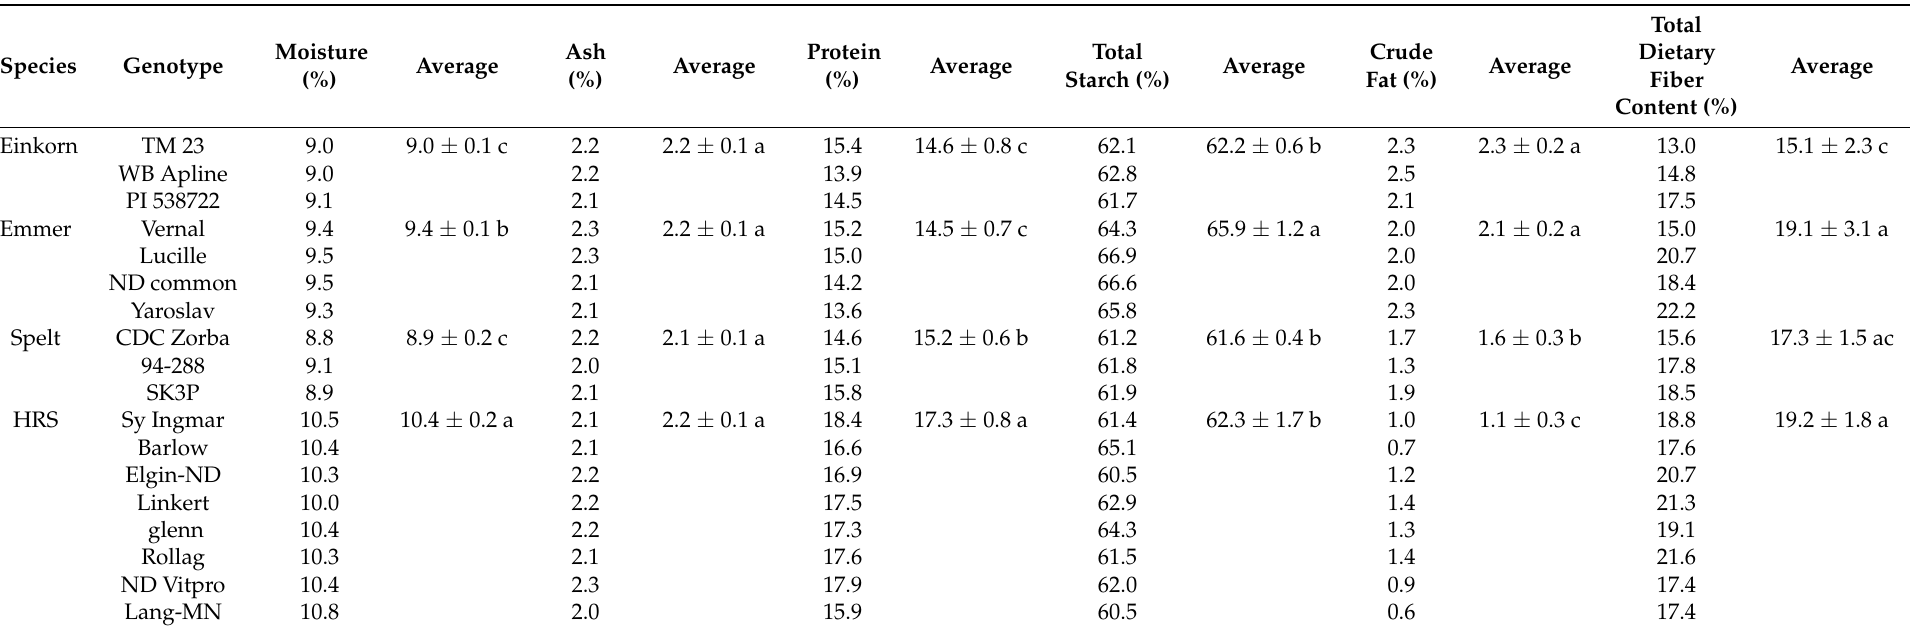
Table 2. Chemical composition of whole wheat flour of einkorn, emmer, spelt and hard red spring